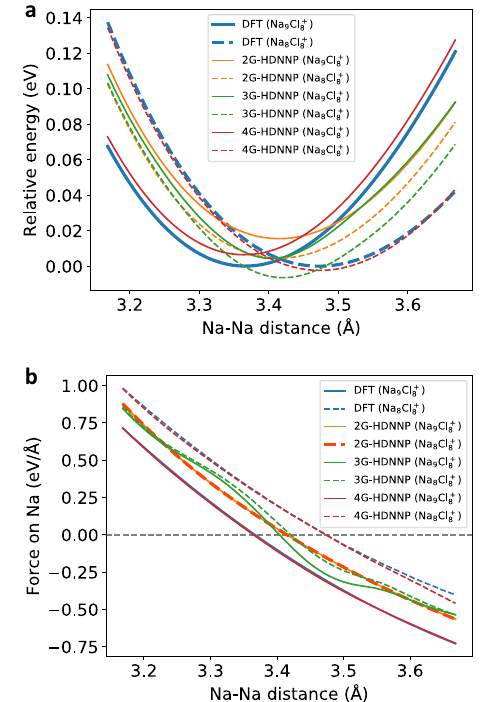
Fig. 7 Relative energies and forces of the NaCl clusters. a Relative energies of all potentials with respect to the DFT minima of the Na 8 Cl þ the Na 9 Cl þ clusters as a function of the Na – Na distance and b forces acting 8 on the blue sodium atom for the the path shown in Fig. 6. For the 3G- HDNNP unscaled charges have been used in this